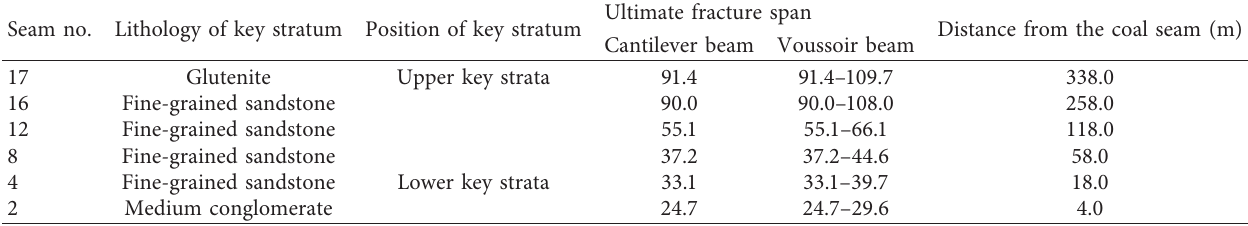
Table 4: Ultimate fracture span of key stratum in No. 8100 longwall face.